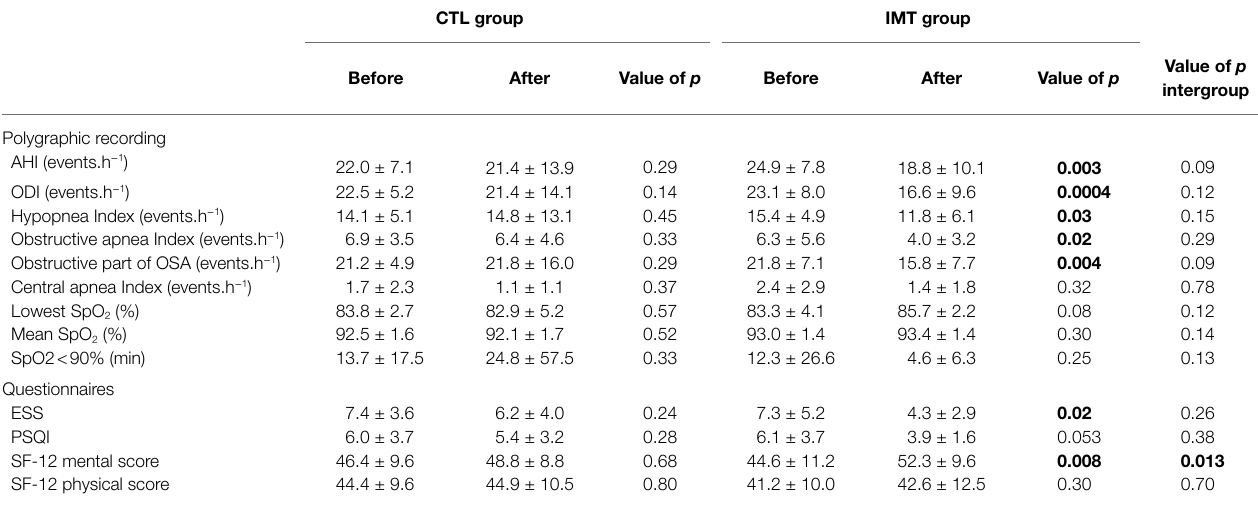
TABLE 3 | Average values of polygraphy and questionnaires before and after cardiac rehabilitation in the control (CTL) and inspiratory muscle training (IMT) groups. CTL group IMT group Before After Value of p Before After Value of p